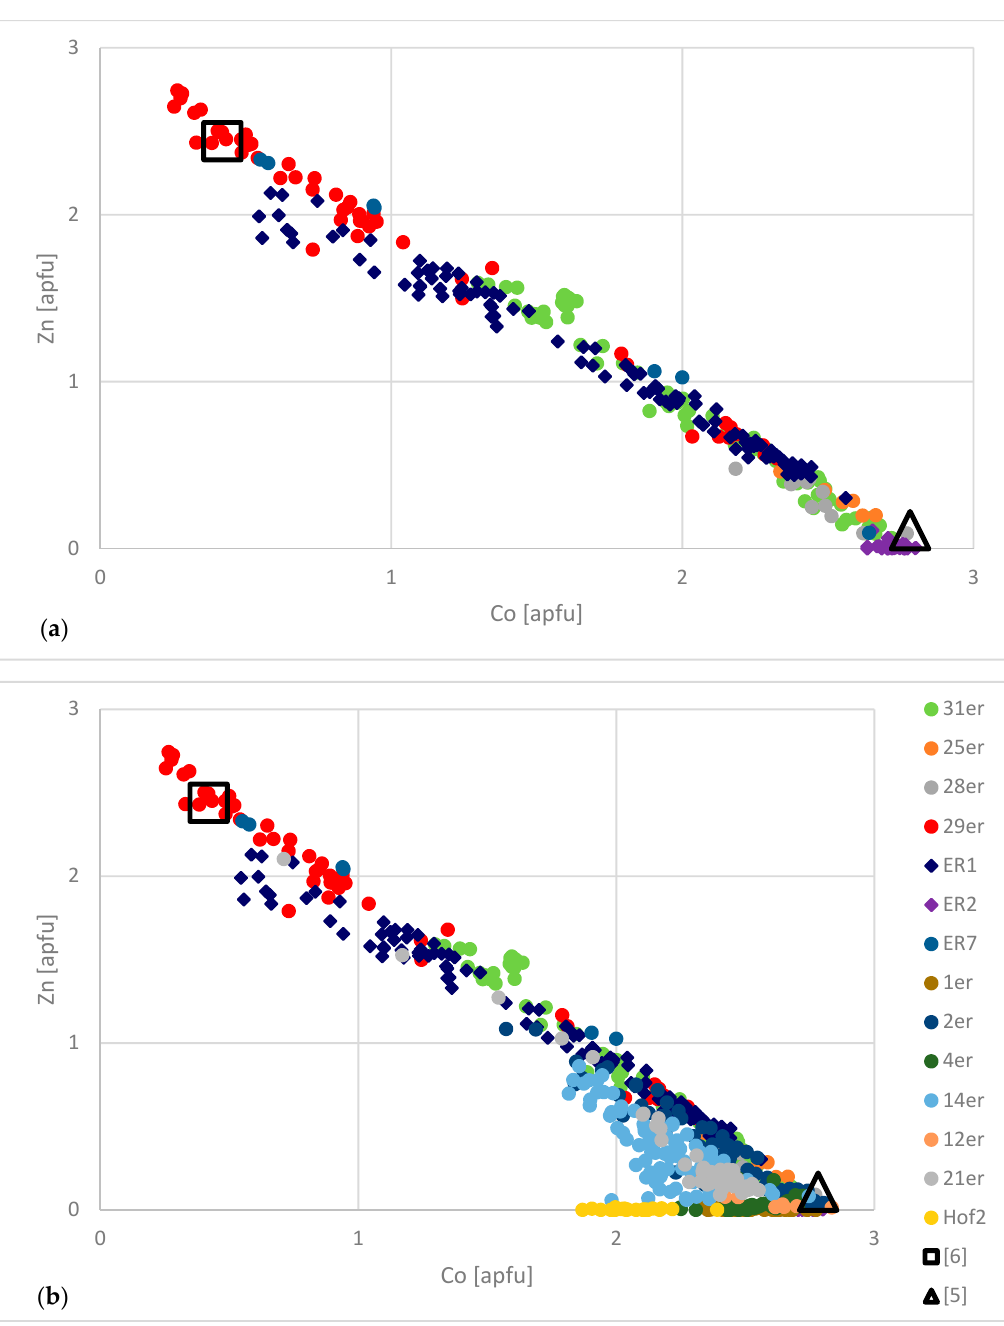
Figure 6. Plot of Co vs. Zn in atoms per formula unit (apfu): ( a ) in the erythrite–köttigite solid solution singled out from all analyses shown in ( b ). Symbols refer to 14 samples from Miedzianka and data in the literature.